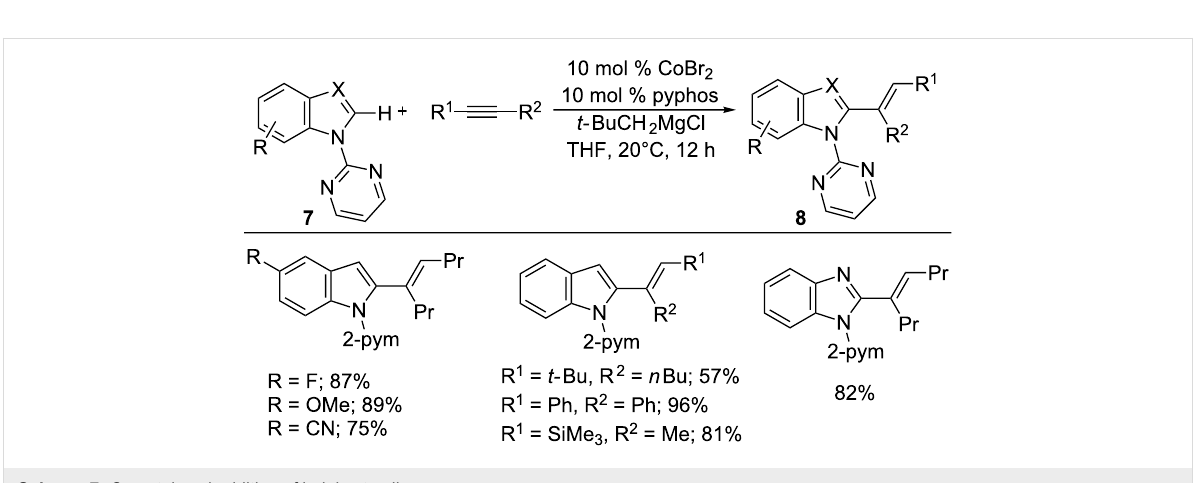
Scheme 7: Co-catalyzed addition of indoles to